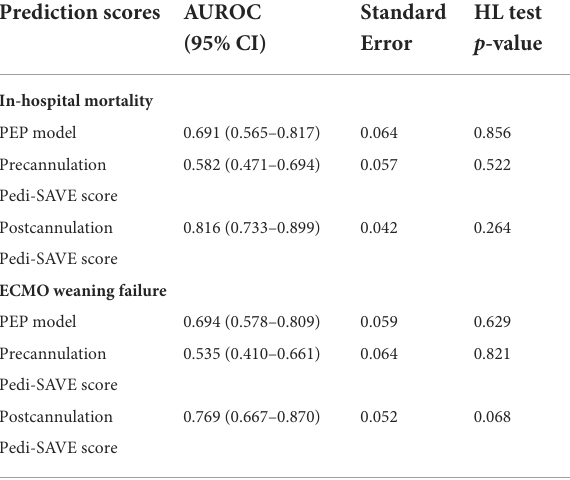
TABLE 4 Performance of prediction